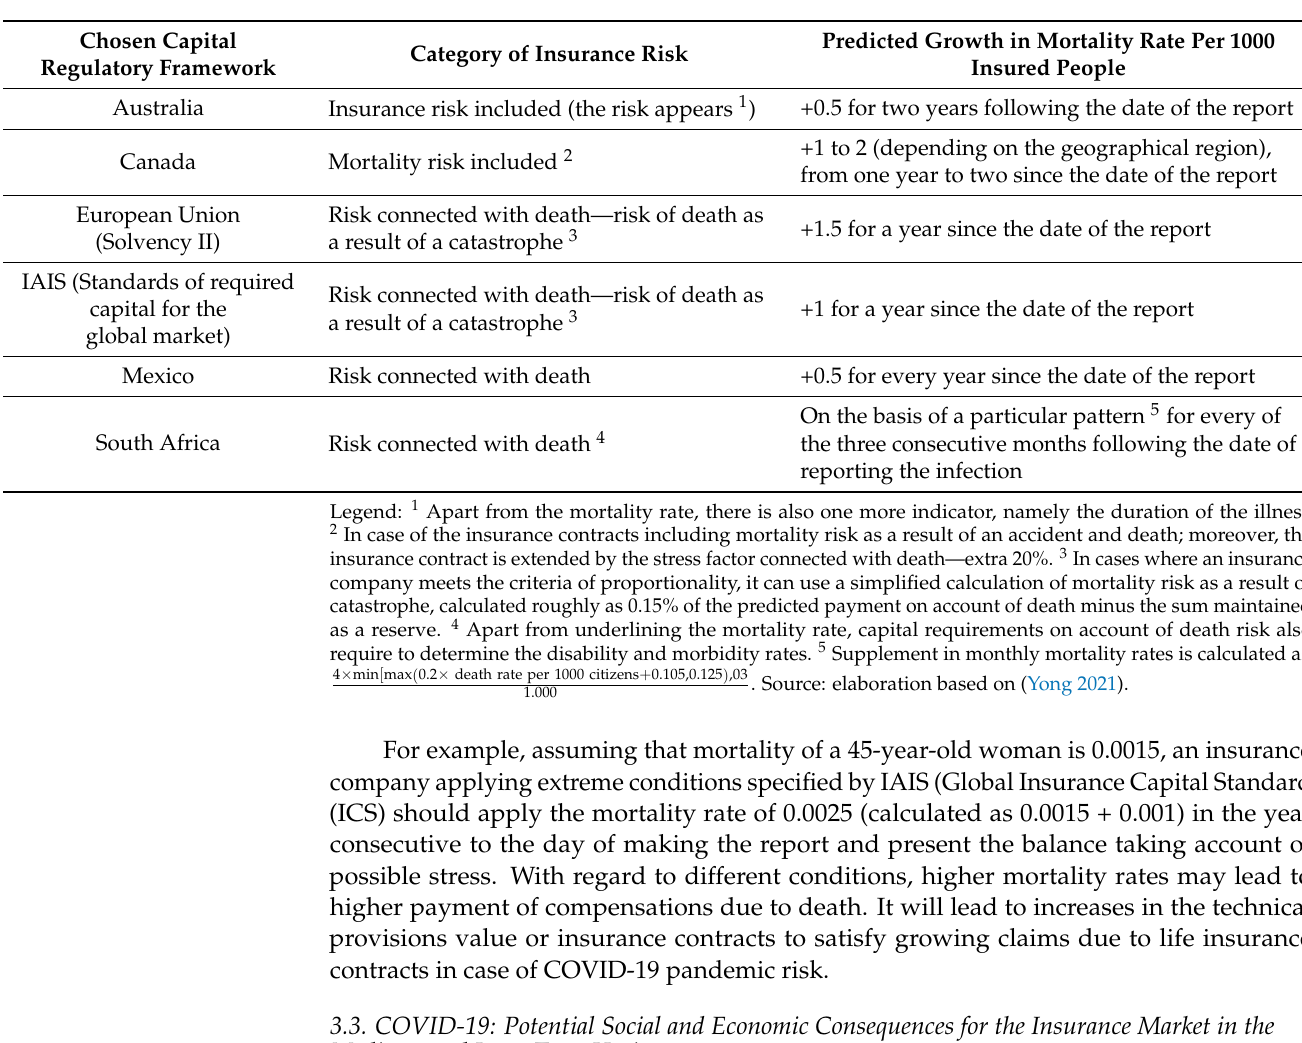
Table 3. Capital requirements arising from mortality risk during the COVID-19